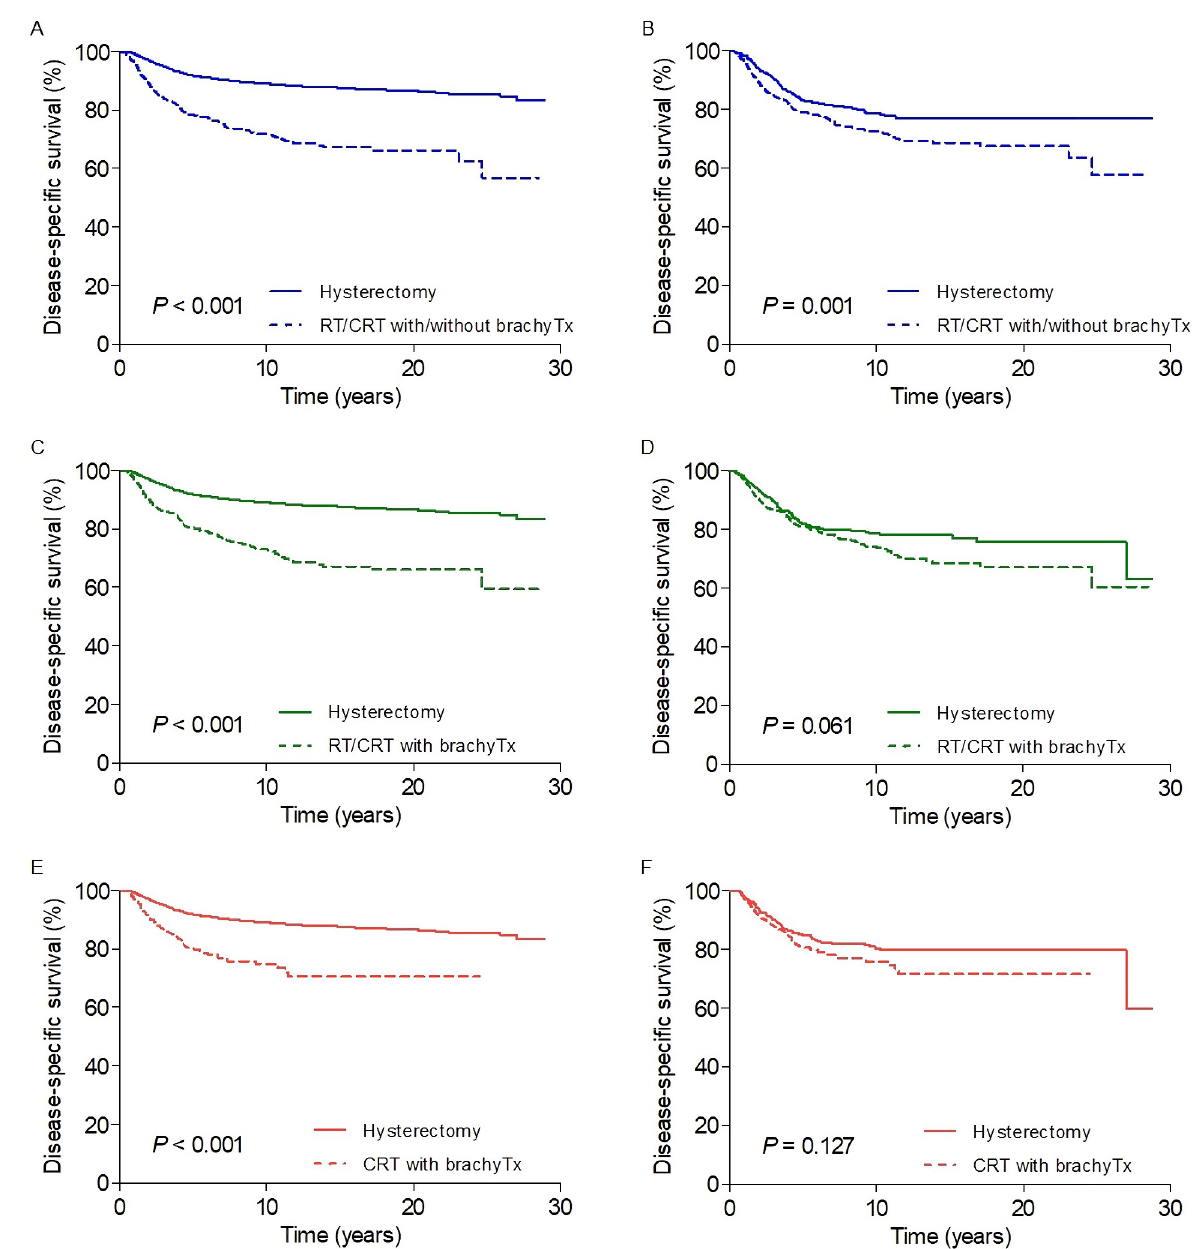
Fig 2. Disease-specific survival according to hysterectomy and primary radiotherapy (A, C, E) before and (B, D, F) after propensity score matching in cohorts A ( blue ), B ( green ), and C ( red ), respectively. RT, radiotherapy; CRT, chemoradiotherapy; brachyTx, brachytherapy.